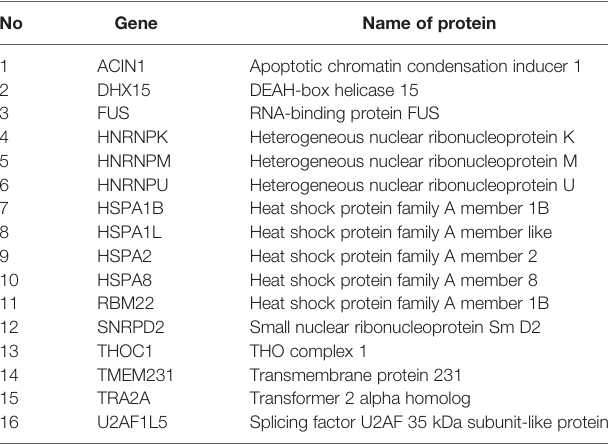
TABLE 4 | Spliceosome proteins detected with MG-H1 modi fi cation in HEK293 cells treated with methylglyoxal in vitro